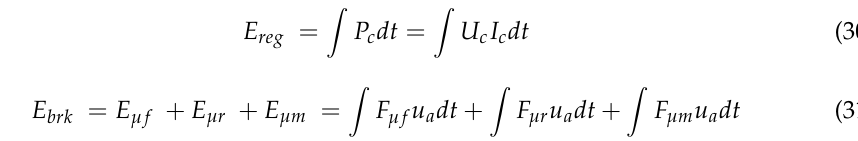
Table 2. The calculation of energy recovery rate.